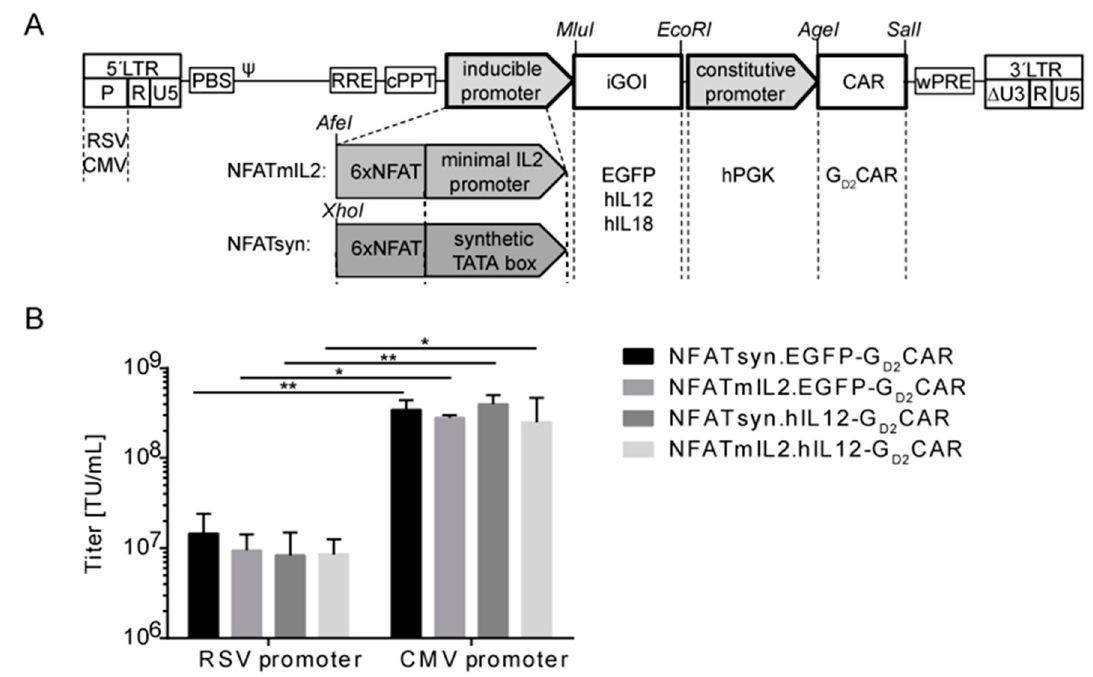
Figure 2. Schematic depiction of the modular “all-in-one” vector construct. ( A ) Lentiviral SIN vector scheme representing the main “all-in-one” construct elements and additional modifications. The vector plasmid configurations with indicated restriction sites are shown. The promoter sequence (P) in the 5´Long Terminal Repeat (LTR) is derived from Rous sarcoma virus (RSV) or cytomegalovirus (CMV). The construct is composed of a constitutively expressed G D2 CAR element driven by a human phosphoglycerate kinase (hPGK) promoter and an inducible element consisting of six consensus NFAT enhancer repeats and the corresponding promoter (minimal IL2 promoter (mIL2) or synthetic TATA box (syn)) followed by the inducible gene of interest, respectively. ( B ) CMV-driven lentiviral “all-in-one” vector constructs led to improved lentiviral vector production. Constructs were pseudotyped with vesicular stomatitis virus glycoprotein (VSVg). Titration was performed in human HT1080 fibroblasts based upon G D2 CAR expression as analyzed via flow cytometry three days post transduction. Bar graphs depict mean values ± SD ( n = 3) of viral vector titers determined as described in Section 4.3. Indicated significance was determined by one-way ANOVA with Tukey´s multiple comparison test; ** p ≤ 0.01; * p ≤ 0.05; ns > 0.05). iGOI, inducible gene of interest.